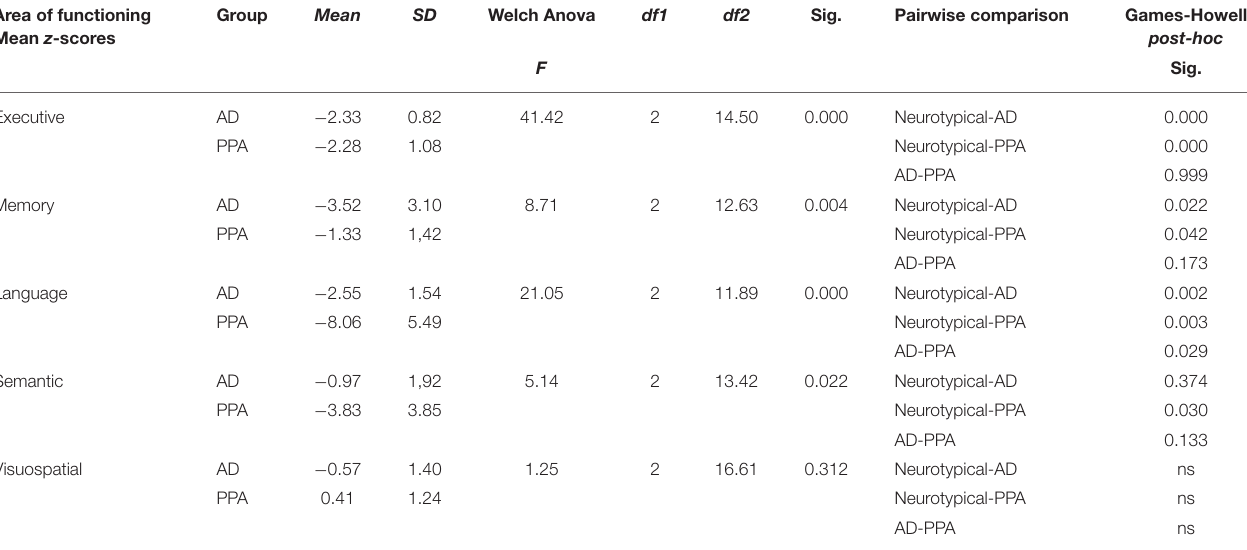
TABLE 5 | Group comparisons with mean z-